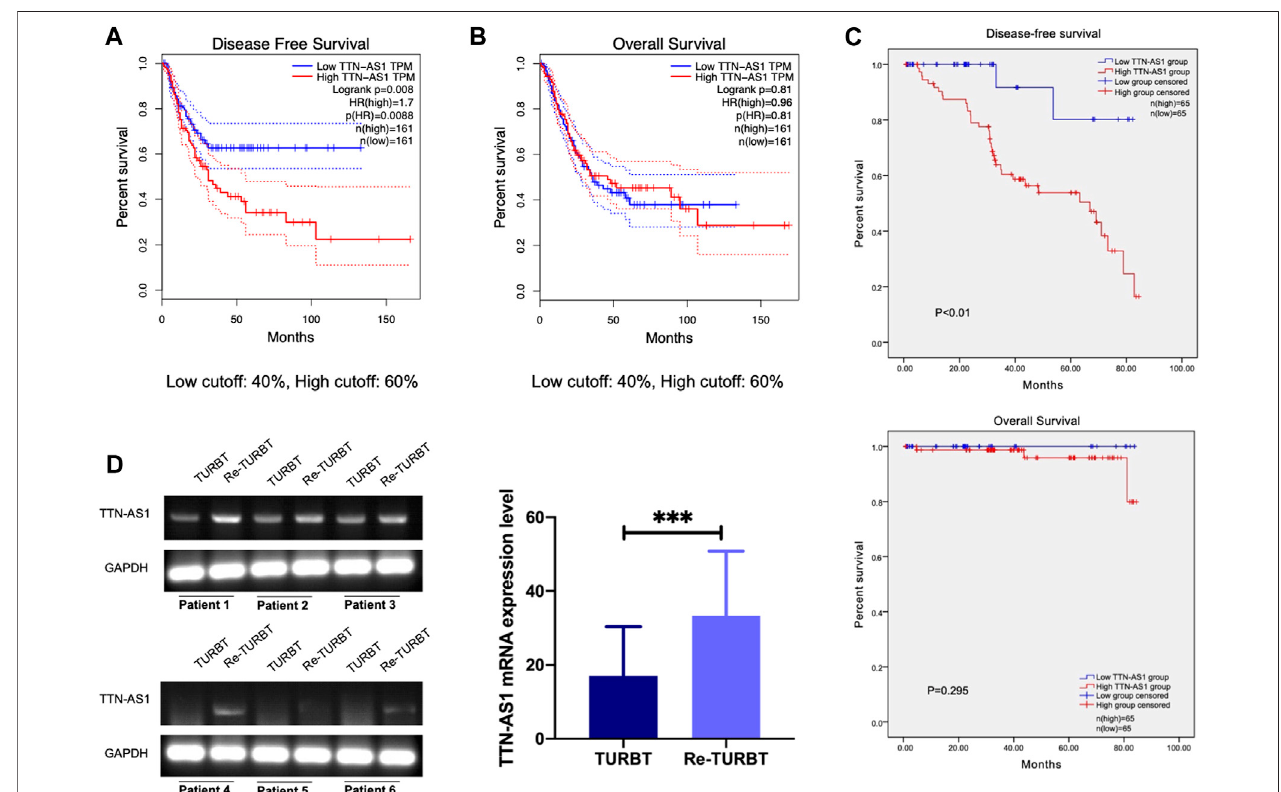
FIGURE 1 | LncRNA TTN-AS1 was upregulated in nonmuscular invasive BC who underwent TURBT and is related with adverse DFS (A) . The DFS of BC patients fromTCGAdatabase( n (cid:1) 322, p (cid:1) 0.0088) (B) .TheOSofBCpatientsfromTCGAdatabase( n (cid:1) 322, p (cid:1) 0.81) (C) TheDFS( p < 0.01)andOS( p < 0.295)ofBCpatients from our institution ( n (cid:1) 130) (D) . qRT-PCR was used to detect the expression level of lncRNA TTN-AS1 at mRNA level in surgical specimens of BC patients who underwent TURBT and Re-TURBT (*** means: p <